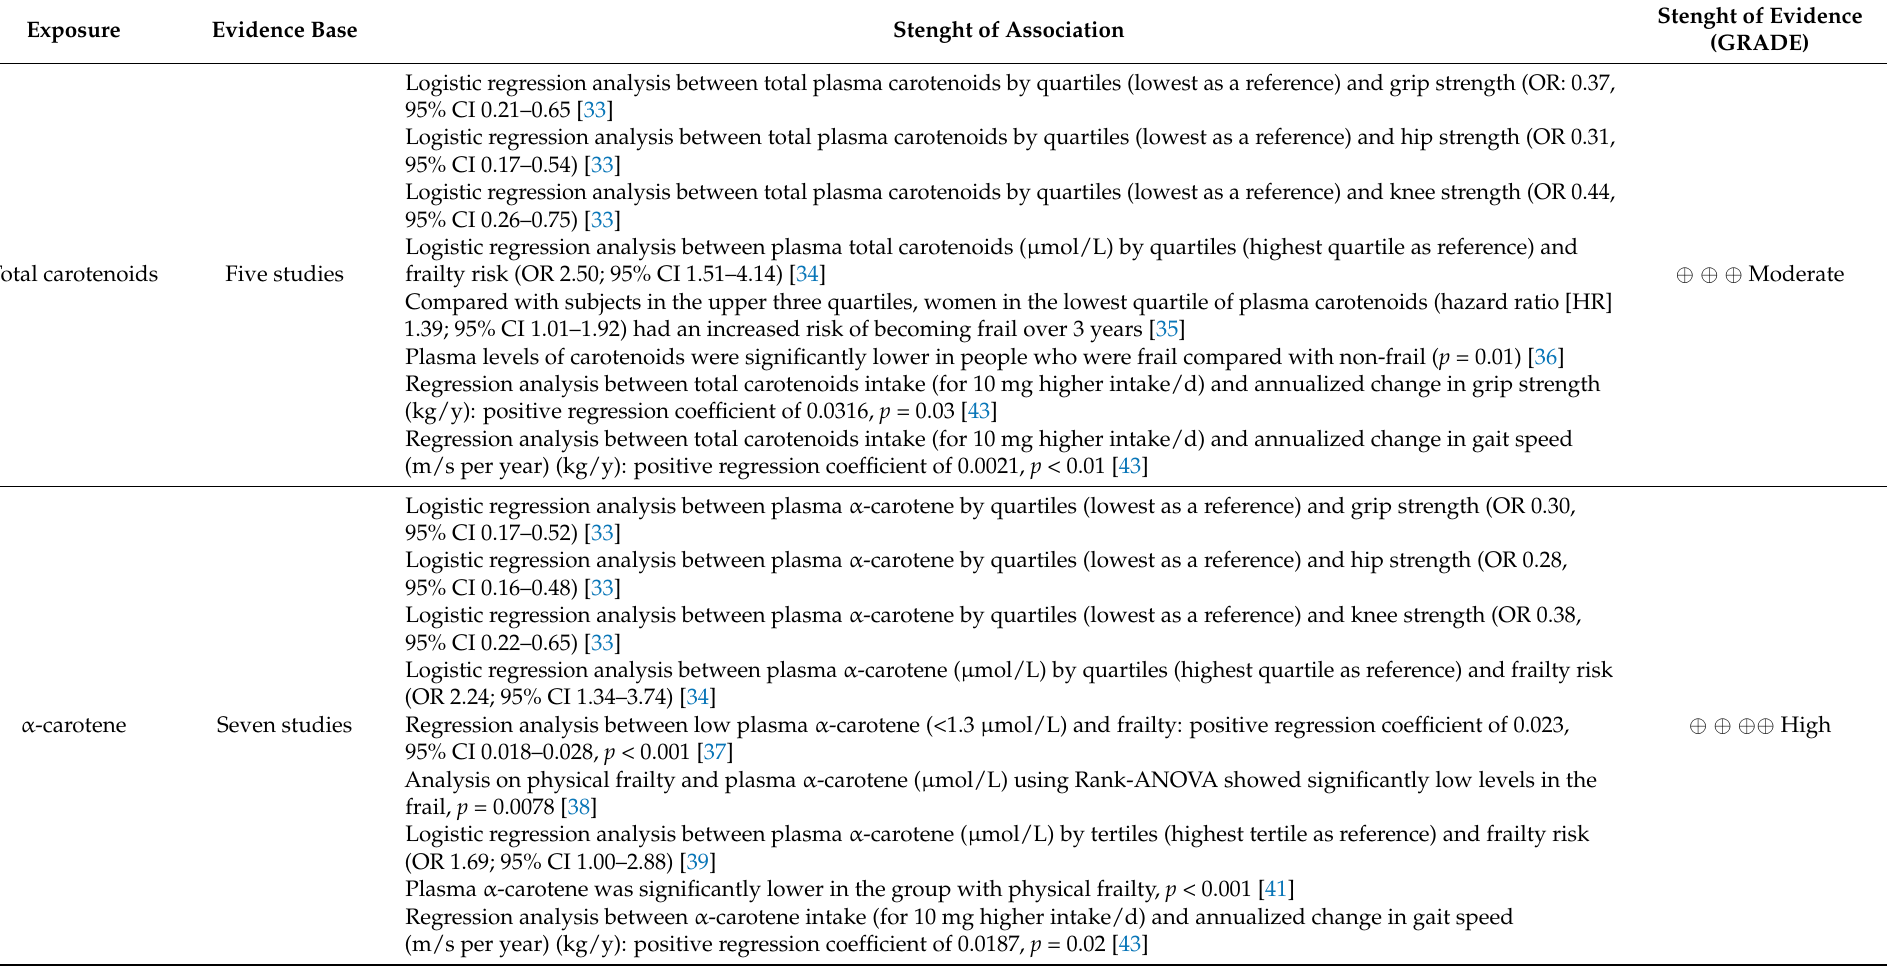
Table 4. Summary of findings on the relationship between carotenoids and physical